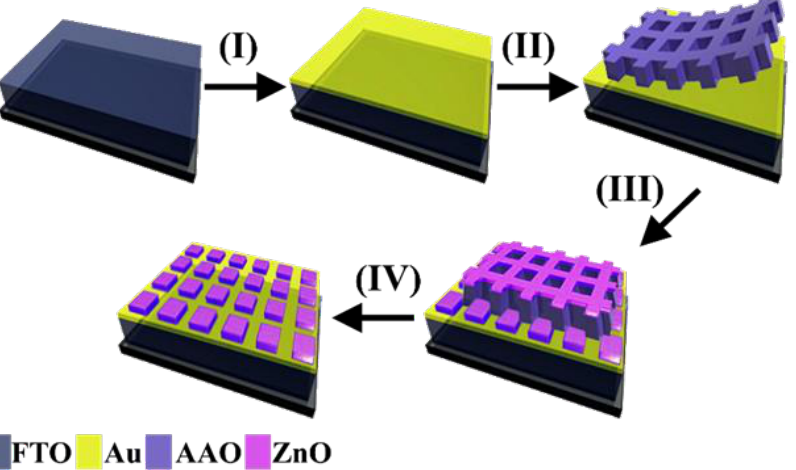
Figure 11. Illustration of ZnO/Au nanosquare array fabrication: (I) Deposition on a thin Au layer of around 5 nm, (II) Transferring AAO template onto FTO glass, (III) Deposition of ZnO, and (IV) removal of UTAM template.